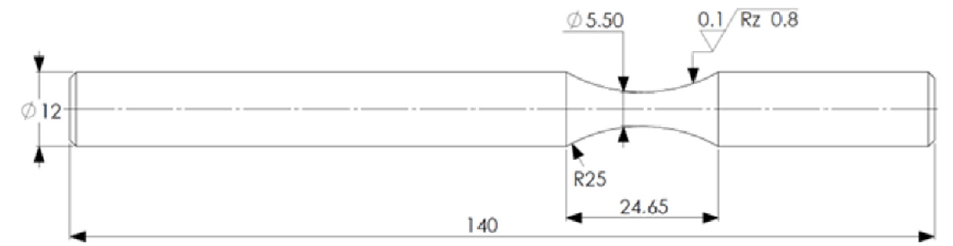
Table 2. Mechanical characteristics of steel after heat treatments cycle.